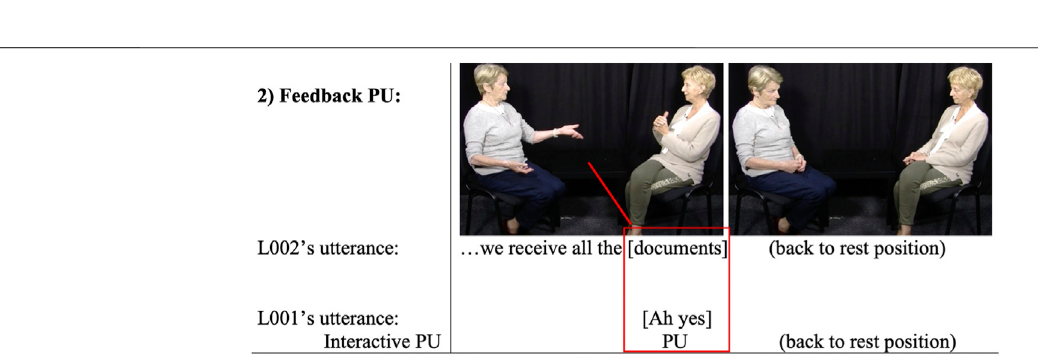
FIGURE 4 | Turn-Opening PU by L002 (FRAPé Corpus, 02:52.999-02:56.276).